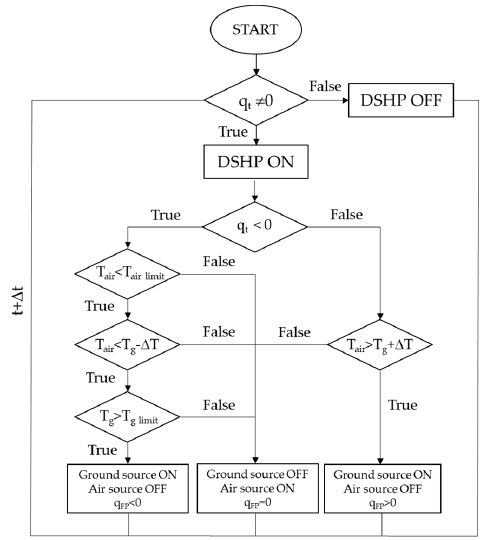
Figure 6. Flowchart of DSHP performance routine for heating and cooling mode.